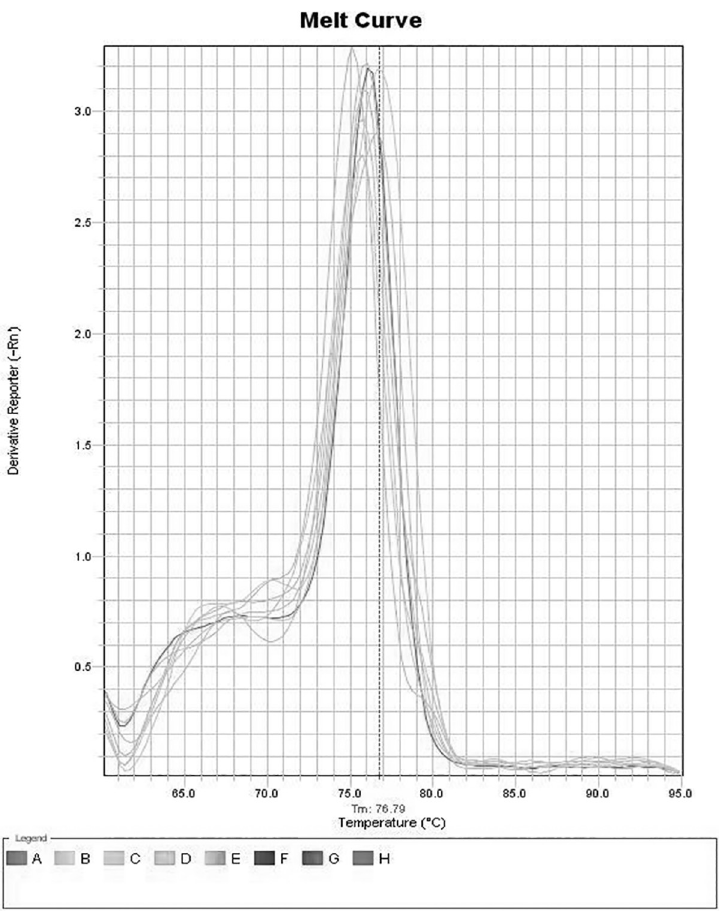
Fig 9. Melt curve of CCA1 gene-specific primers employed in qRT-PCR analysis of various T1 transgenic progeny plants of rice.